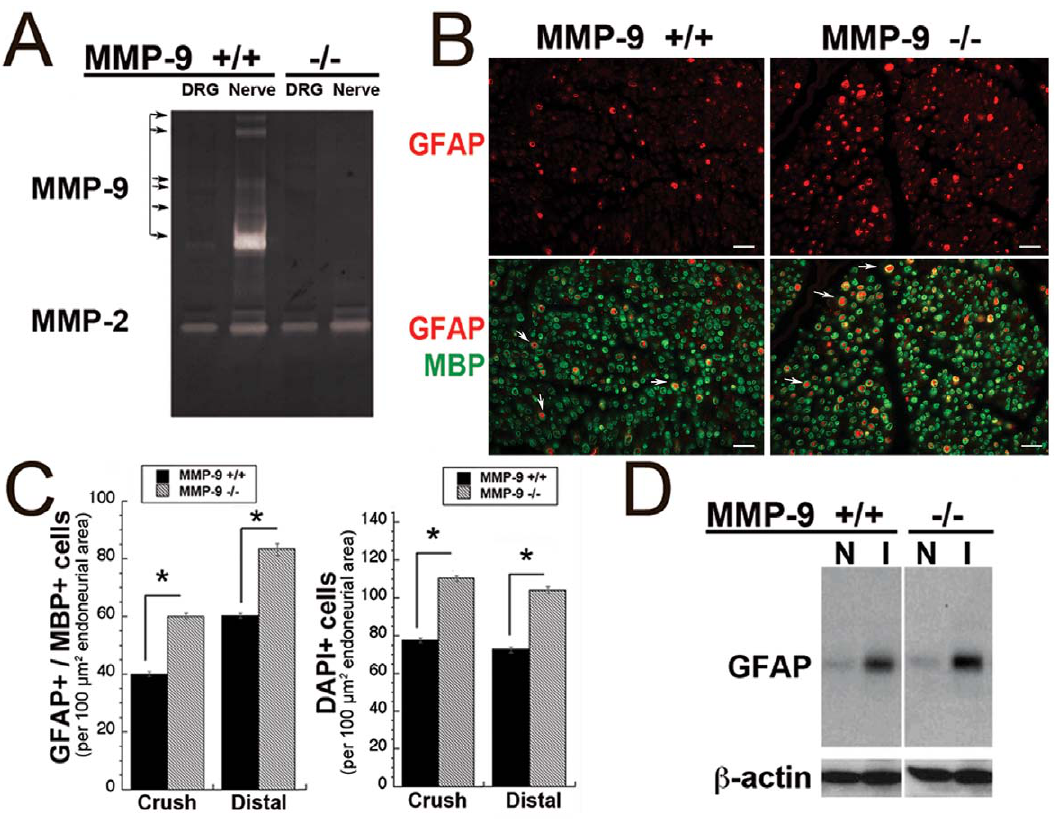
Figure 5. Immature mSCs accumulate in crushed MMP-9 KO nerves. A, Gelatin zymography of the sciatic nerve and the L4/5 DRG 24 h post- crush samples in MMP-9 + / + and MMP-9 2 / 2 mice. MMP-9, but not MMP-2 was diminished in MMP-9 2 / 2 samples (n=2/lane, pooled). B, Immunofluorescence of GFAP (red) and MBP (green) at day 5 post-injury in MMP-9 2 / 2 and MMP-9 + / + . Transverse nerve section, crush site (representative of n=3/group), Scale bar, 40 m m. Increased number of immature, GFAP + mSCs in MMP-9 2 / 2 nerves. C, Morphometry of B and of DAPI-positive cell counts at the crush site and 10–20 mm distal to crush site. (*, p , 0.05). D, Immunoblotting for GFAP ( , 45 kDa) and b -actin in the naive (N) and injured (I) nerve at day 5 post-crush (the crush site) in MMP-9 + / + and MMP-9 2 / 2 mice (representative of n=4/group).